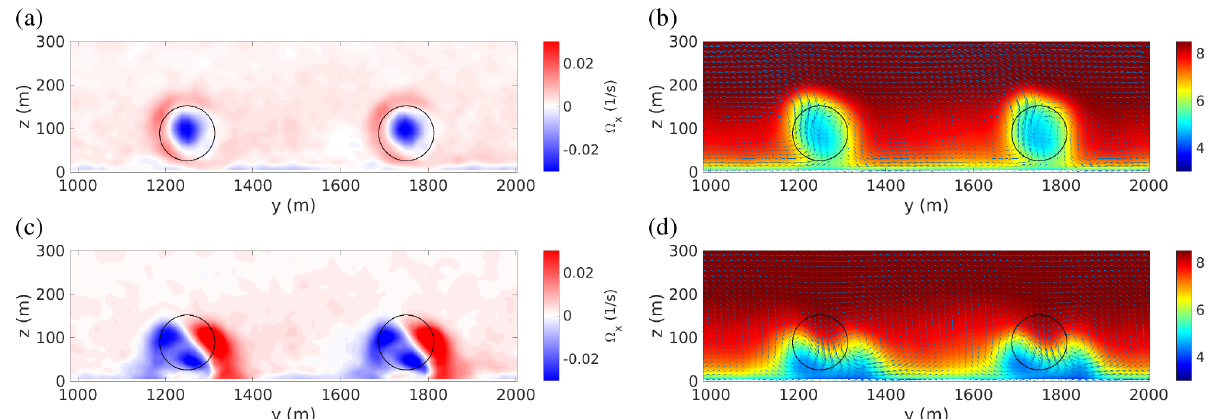
Figure 3. Tilt control: cross-stream view of the mean streamwise vorticity and velocity fields in the baseline case (a, b) and with upwind turbines tilted by ϕ = 30 ◦ and operated at β = − 5 ◦ (c, d) . From the streamwise vorticity fields (a, c) , extracted 3 D downstream of the first turbine row, the negative streamwise vorticity in the wake core associated with wake rotation can be clearly seen in the baseline case (a) as well as its combination with the two counter-rotating streamwise vortices forced by the tilted rotor (c) . Streamwise (color scale) and cross-stream (arrows) velocity fields (b, d) are extracted D/ 2 upstream of the second row of turbines; to improve readability only the fields of the two central turbine columns (between y = 1000 and 2000m) are shown. The circles in black represent the perimeter of downstream